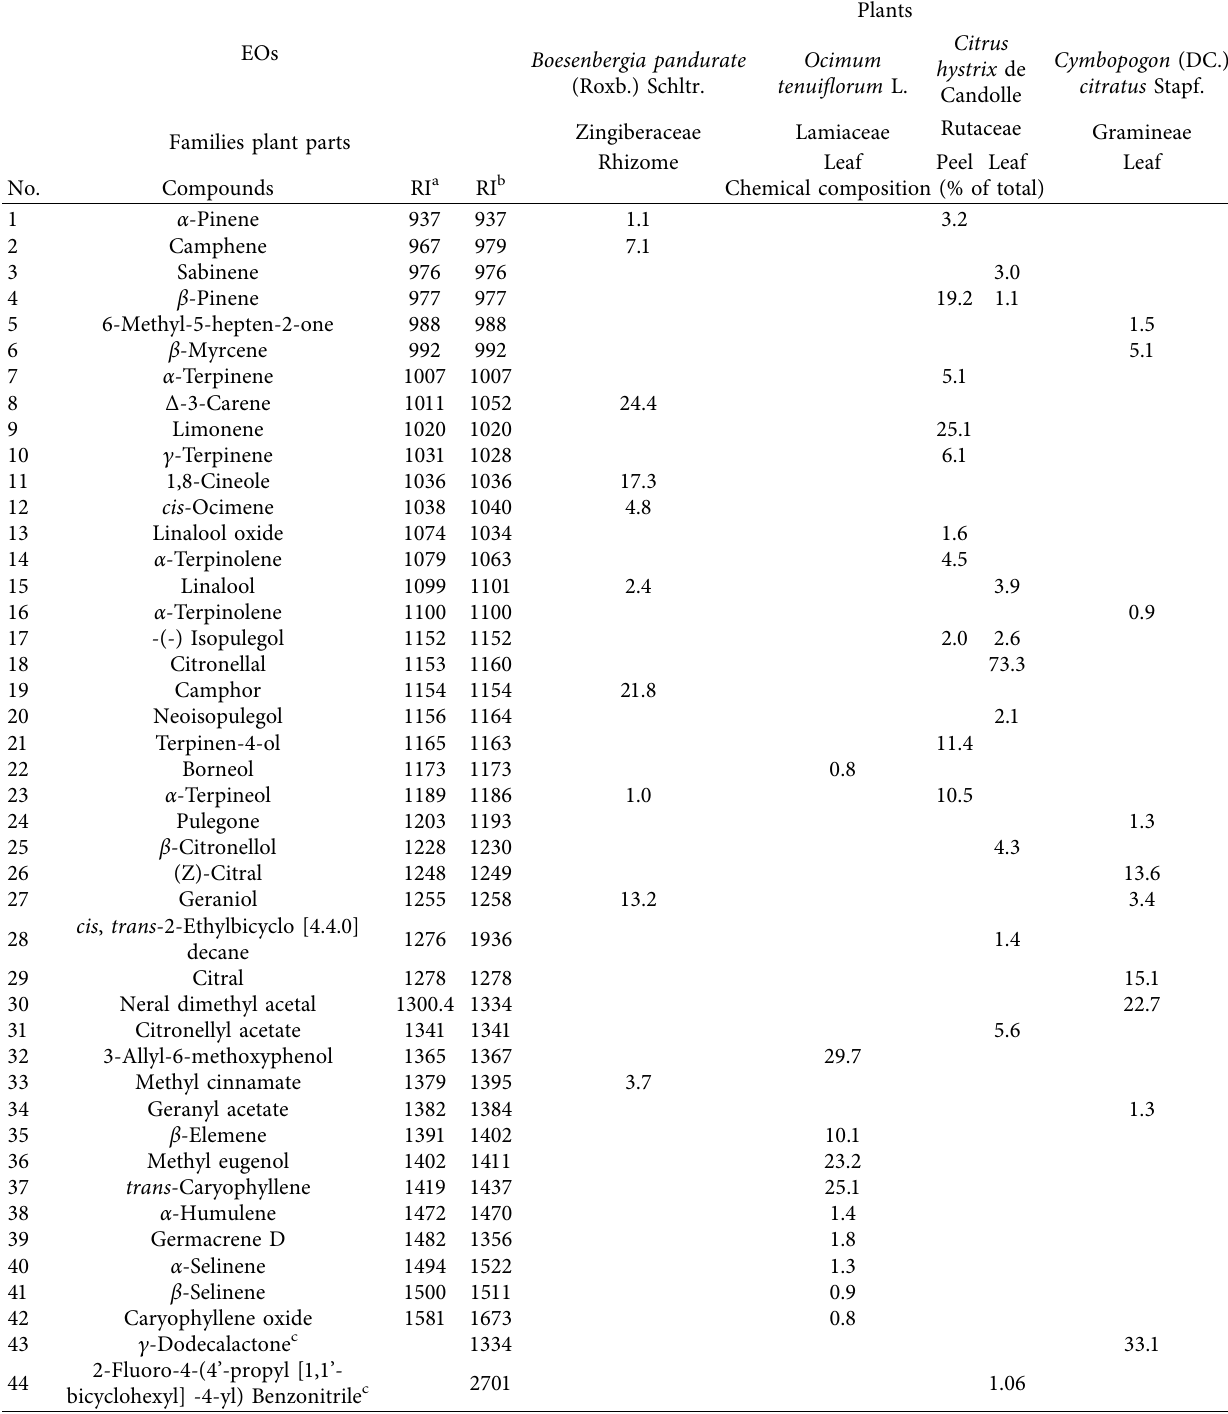
Table 1: Top ten chemical constituents in five Thai culinary